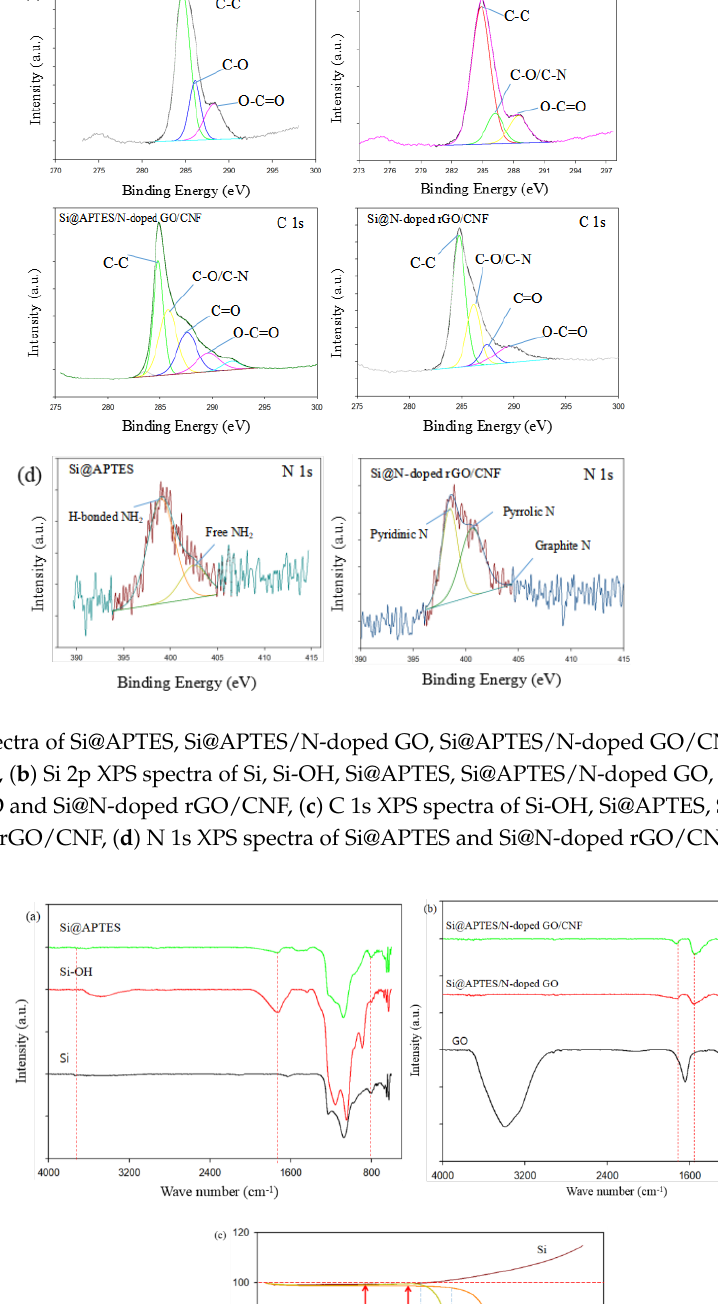
Molecules 2021 , 26 , x